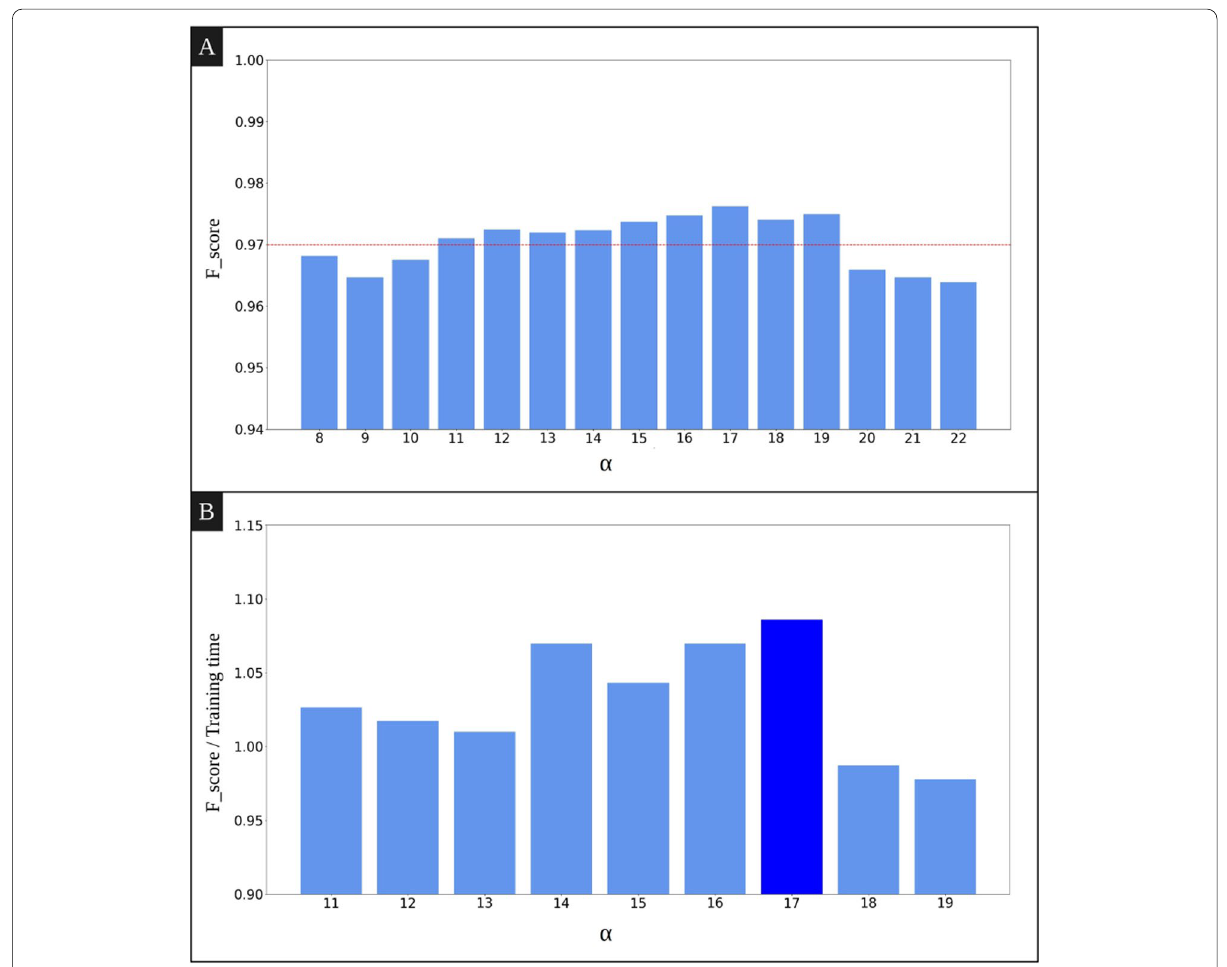
Fig. 7 A F _ score of the model by varying α . The dotted line indicates that the F_score of the model for α values between 11 and 19 is greater than 0.97. B F _ score / Training time for different values of α . Only the values for which the F_score is greater than 0.97 are shown in this figure